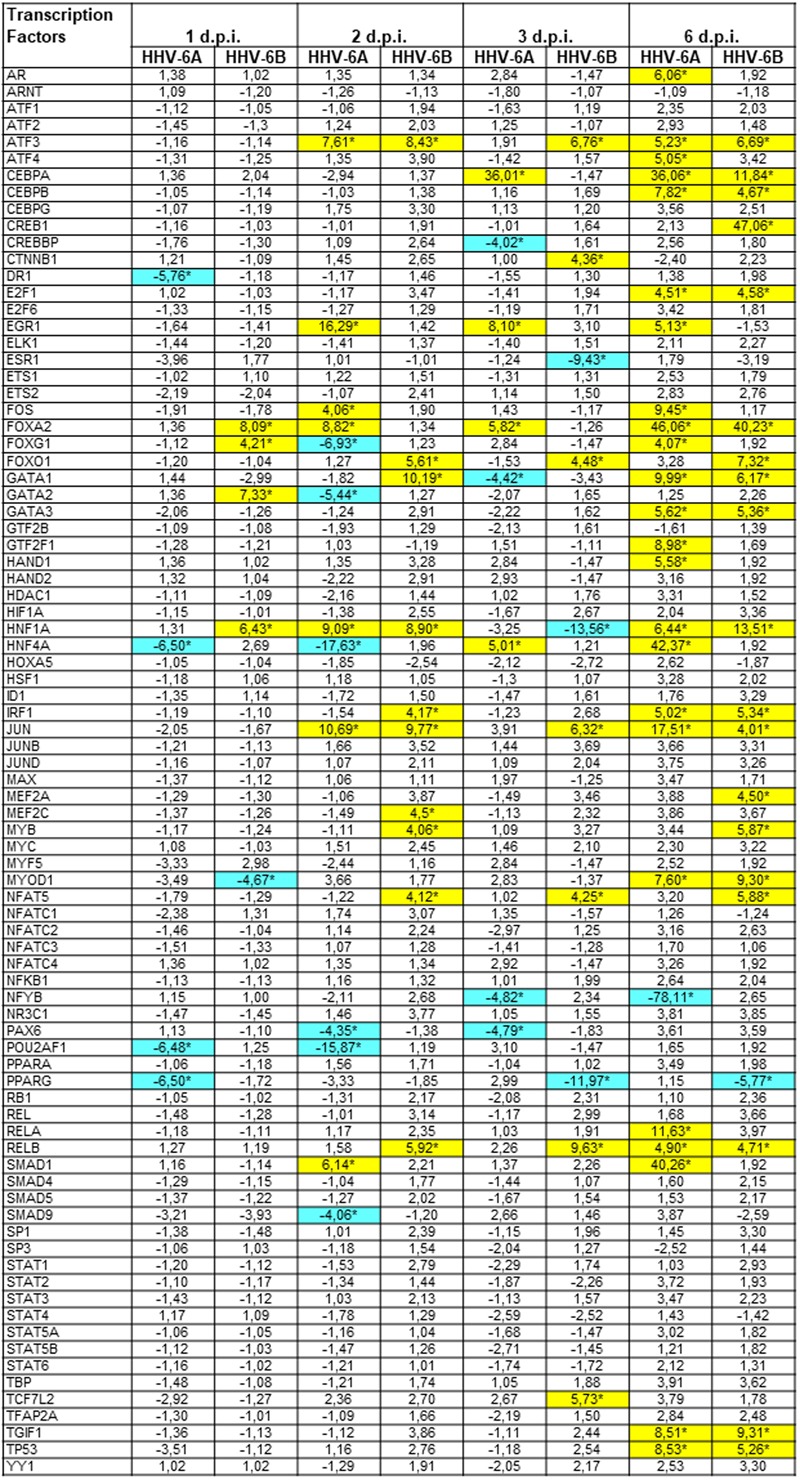
Modulation induced by HHV-6A and 6B infection on human transcription factors mRNAs in NK-92 cells. NK-92 cells were uninfected (control) or infected with HHV-6A or 6B cell-free inocula, then analyzed at 1, 2, 3, and 6 d.p.i. for mRNA expression by a microarray detecting 83 transcription factors. Results are expressed as fold-change compared to control values, and represent the mean value of duplicate samples from three independent experiments. Statistically significant differences after Bonferroni correction are marked with asterisks (pc≤ 0.01) and highlighted by colors (yellow ≥ 4-fold up-regulations; blue ≥ 4-fold down-regulations). Exact pc values of all significant parameters varied from 0.005 to 0.01.